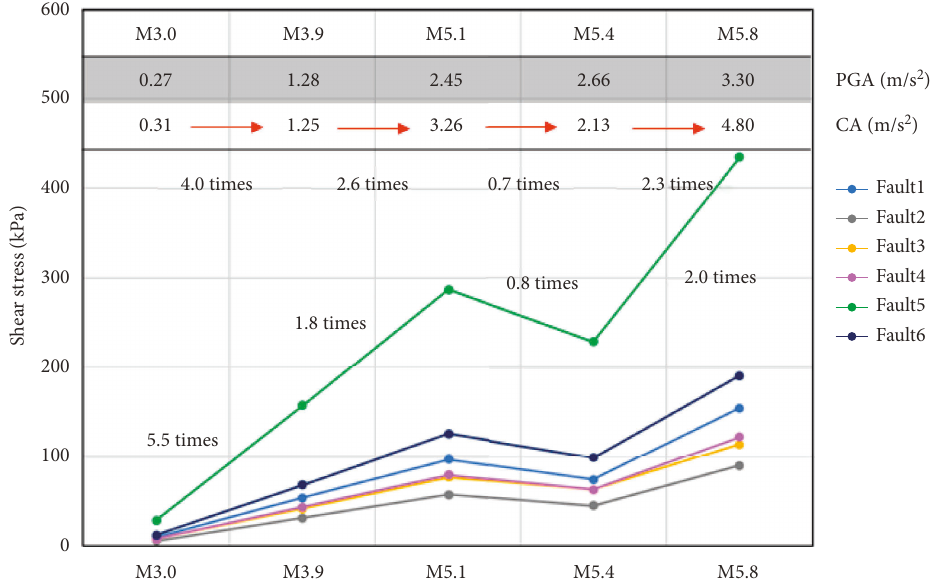
Figure 11: Maximum shear stress, peak ground acceleration (PGA), and cumulative acceleration (CA) of the six fault gouges for each earthquake magnitude. The differences between the CA for each magnitude are similar to the differences between the maximum shear stress for each